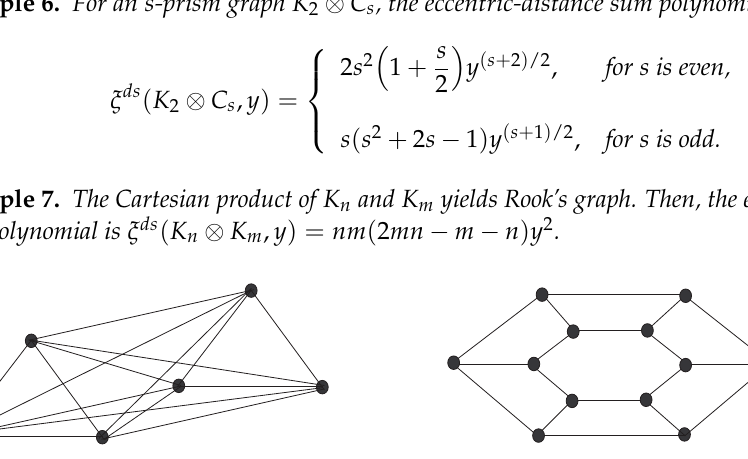
Figure 3. Rook’s graph ( K 3 ⊗ K 2 ) and the 6-prism